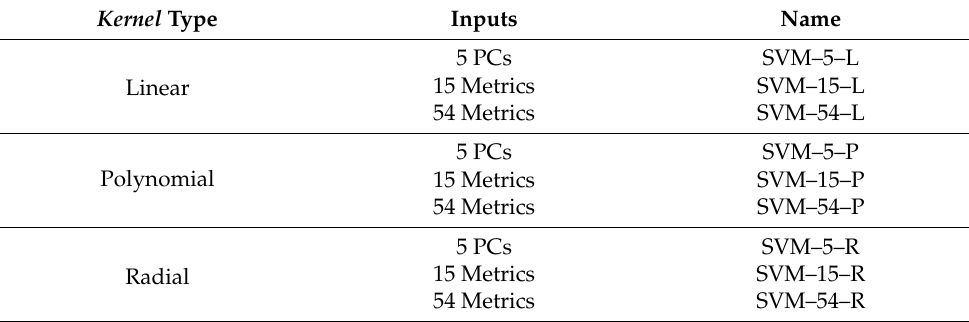
Table 4. Summary of the parameters adopted for modeling using epsilon regression type-support vector machine ( ε